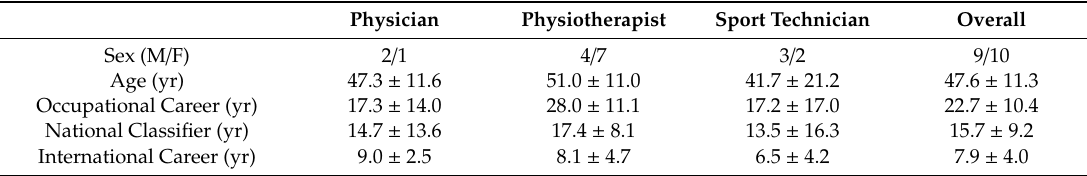
Table 1. Characteristics of the international classifiers (i.e., observers).